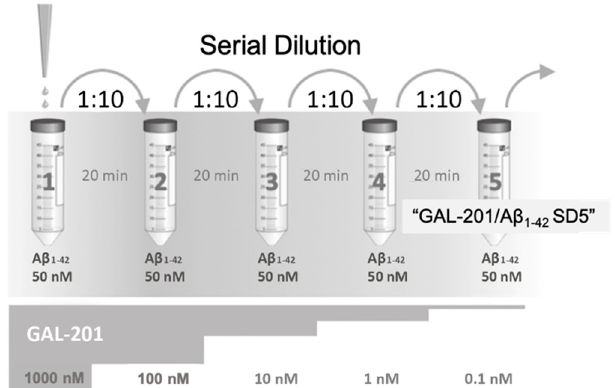
95% CI = − 0.04 to − 0.15; Figure 7).